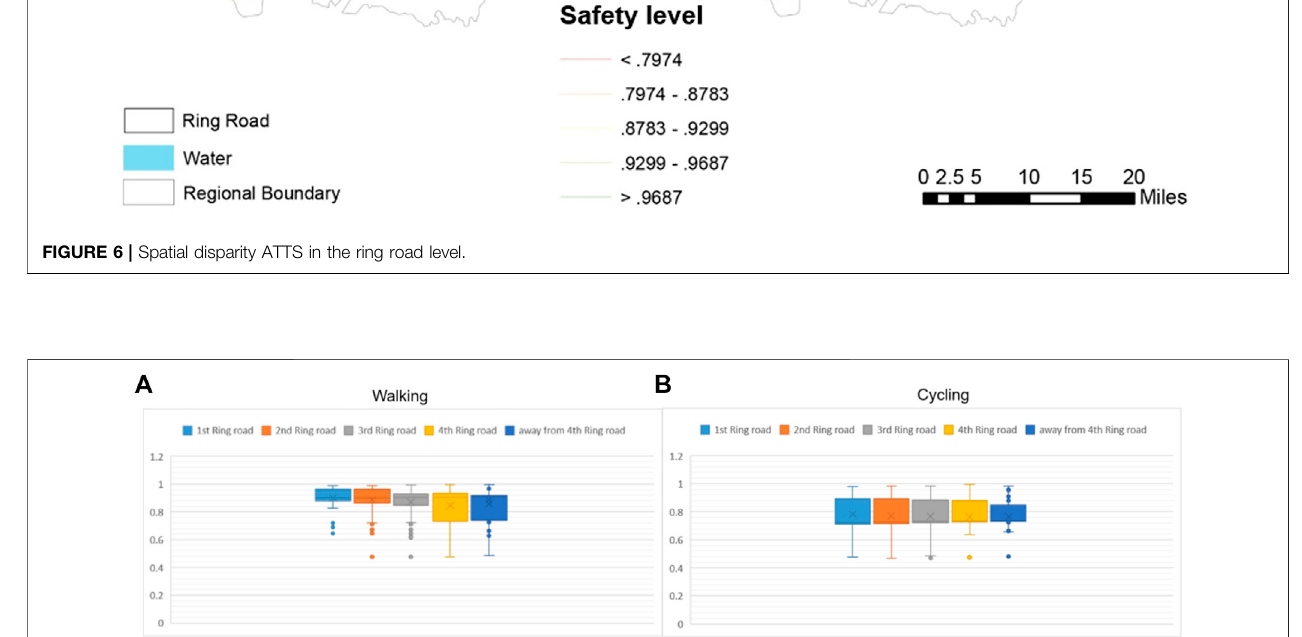
FIGURE 7 | Box plots for ATTS in the ring road